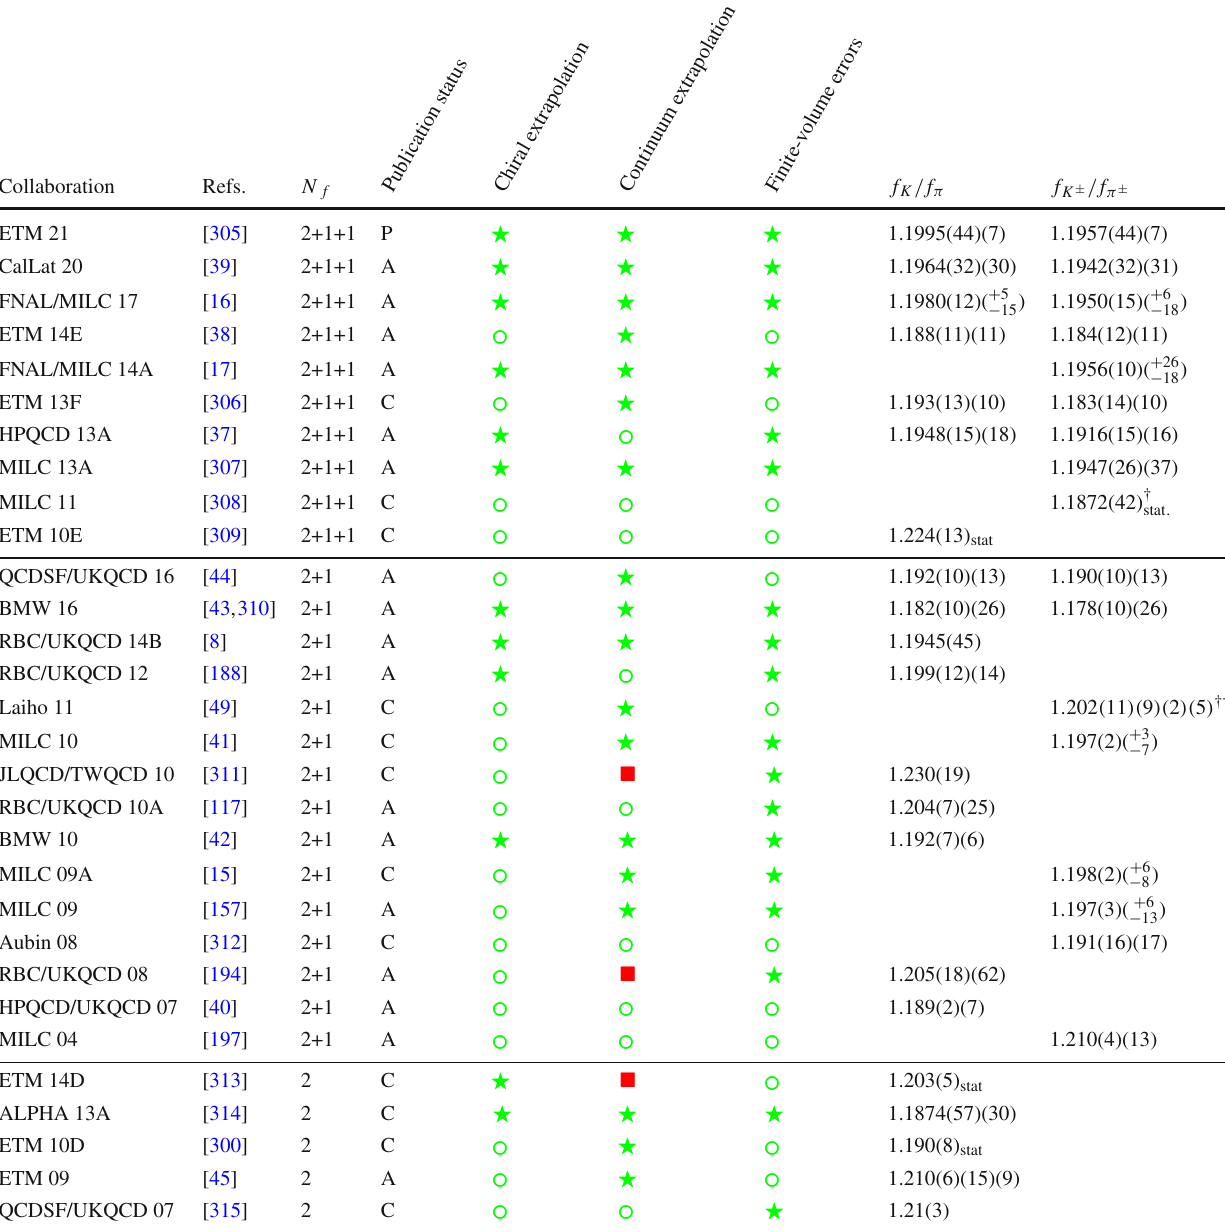
Table 16 Colour code for the data on the ratio of decay constants: f K / f π is the pure QCD SU ( 2 ) -symmetric ratio, while f K ± / f π ± is in pure QCD including the SU ( 2 ) isospin-breaking correction. In this and previous editions [4], old results with two red tags have been dropped